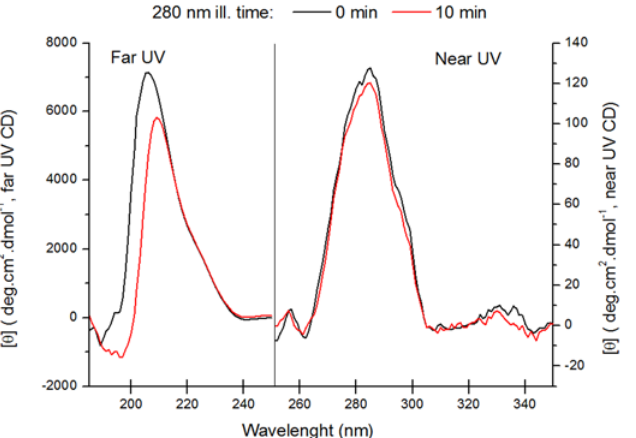
Fig 11. Far and near UV circular dichroism spectra of human plasminogen. Far UV (185 – 250 nm) and near UV (250 – 350 nm) CD spectra were obtained before and after 280 nm light continuous illumination (10 min) of human plasminogen in solution. 280 nm illumination leads to a loss of far UV ellipticity signal at 206 nm (33.4%) and to a red-shift in wavelength of maximum ellipticity (206 nm to 209 nm). There are almost no changes in the near UV CD spectrum of plasminogen with 280 nm illumination. After 10 min of 280 nm ill. the ellipticity signal at the wavelength of maximum ellipticity (285 nm) decreases only by